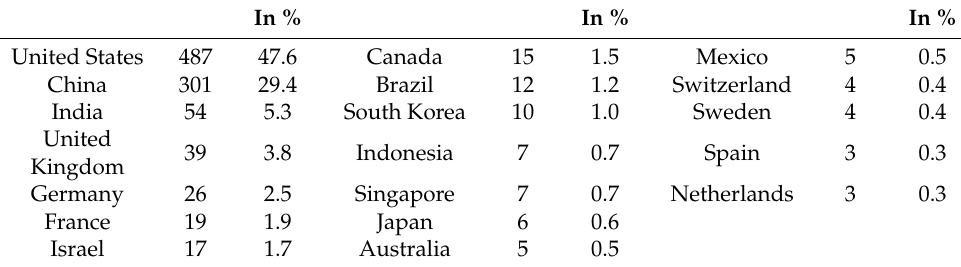
Table 2. Number of global unicorns in 2021, by country.